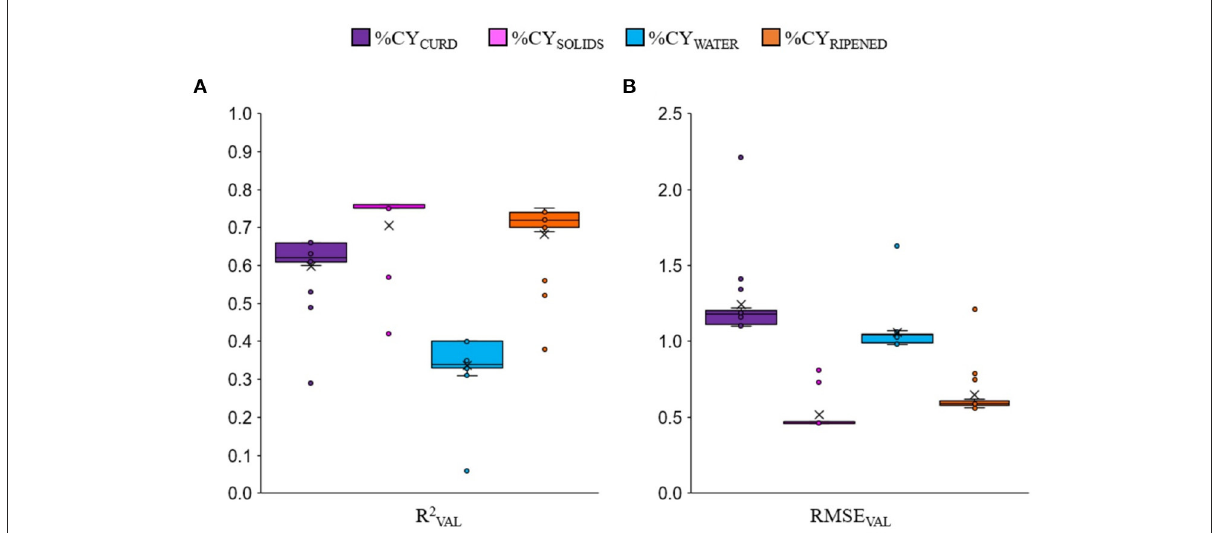
FIGURE1 Box-plot of validation accuracy (R 2 VAL ) (A) and root mean square error (RMSE VAL ) (B) of all the cheese yield prediction equations for fresh curd (%CY CURD ), cheese solids (%CY SOLIDS ), water retained in the curd (%CY WATER ) and 60-days ripened cheese (%CY RIPENED ) among all the tested linear regression models. The outlier values (circles) are relative only to single-nutrient